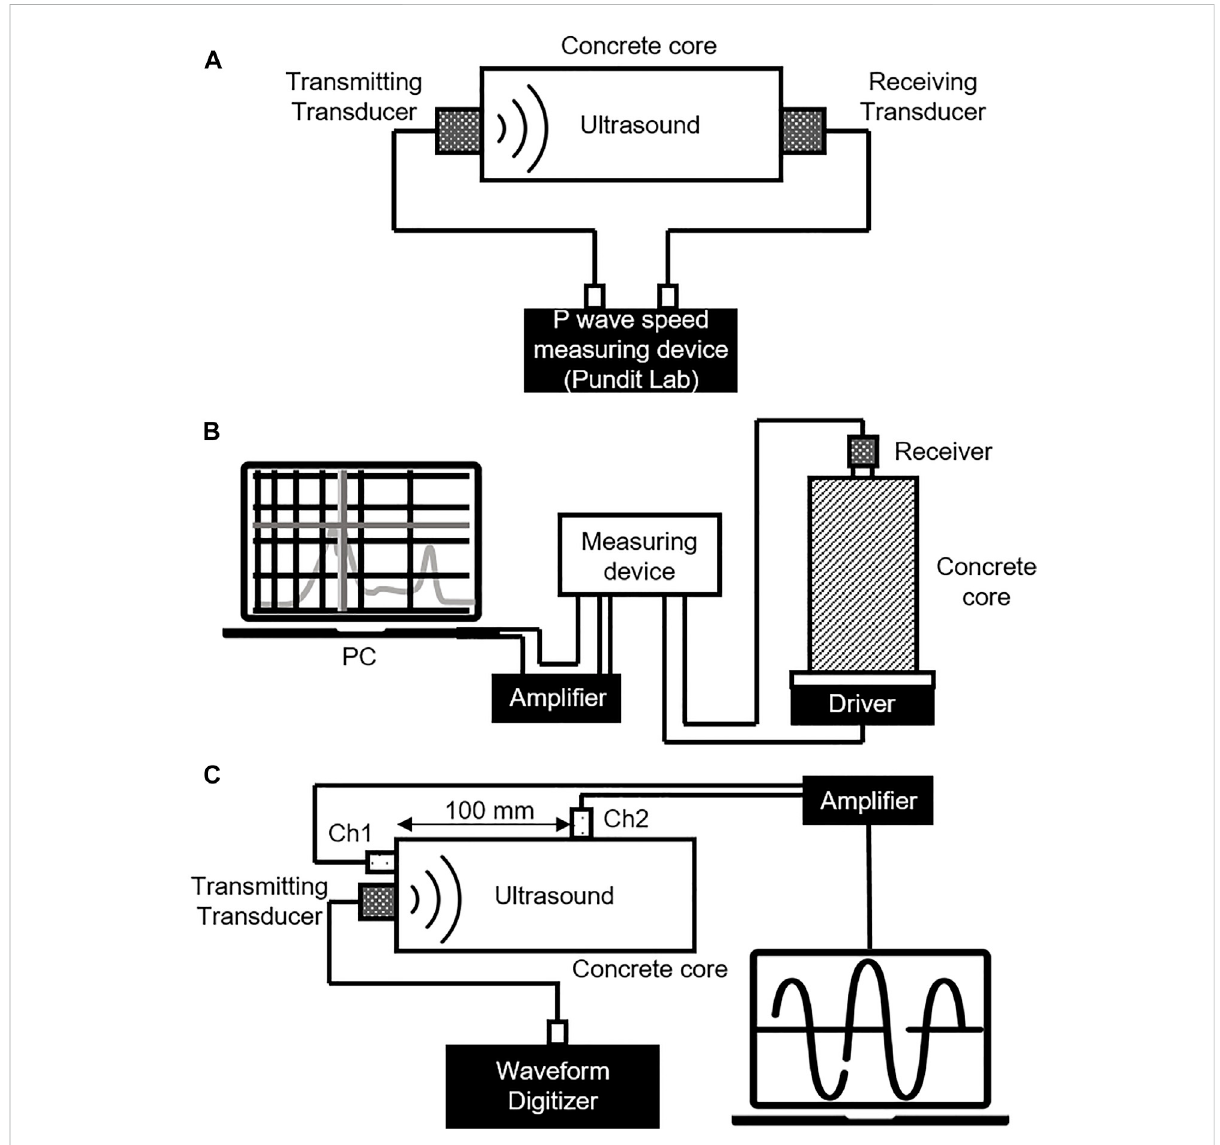
FIGURE 5 Setup of NDT. (A) Pulse velocity test. (B) Resonant frequency test. (C) Acousto-ultrasonic